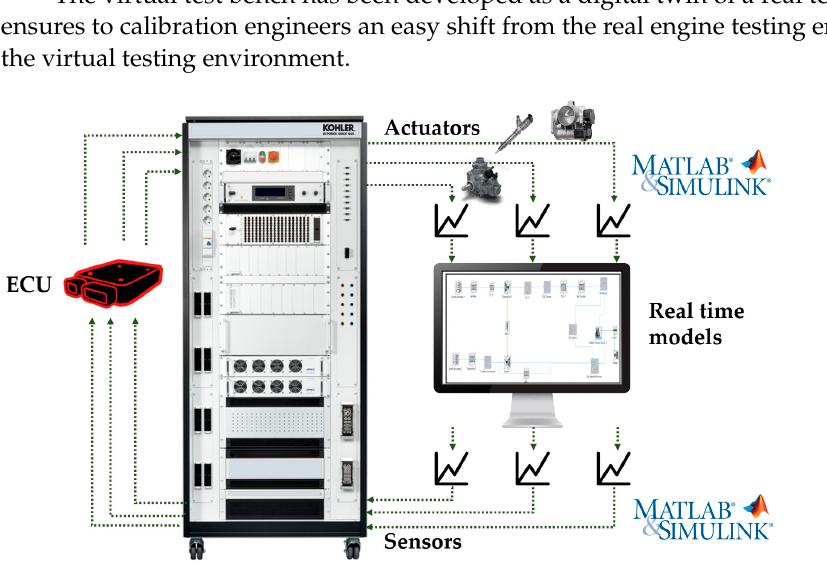
Table 2. Main features of the test engine “Kohler KDI 1903 TCR”. Engine type